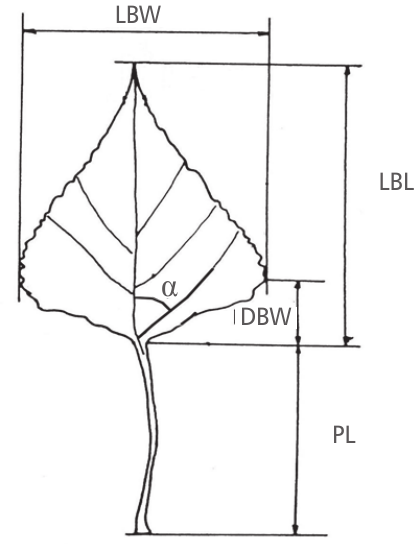
FIGure 2. The investigated leaf morphological traits (LBL - leaf blade length, LBW - leaf blade width, DBW - distance between the leaf widest part and the leaf base, PL - petiole length, α - angle between the first lower lateral vein and the